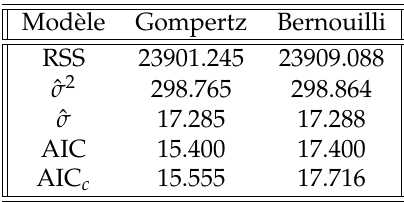
Table 1. Comparison table of Gompertz and